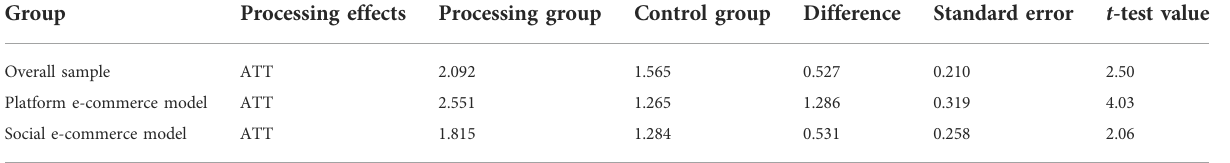
TABLE 6 Marginal effects of each in fl uencing factor on the degree of resettlers ’ adoption of agricultural technology.